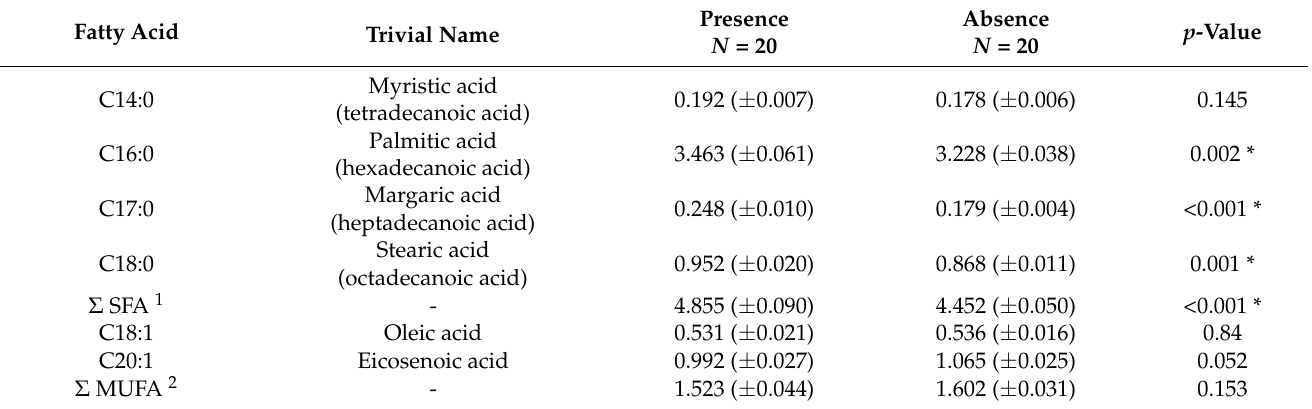
Table 1. Fatty acids composition (mg/g) of groups. Values are mean ± SE. ‘Presence’: the limpet partially covered by the coralline algae, ‘Absence’: the limpet without the coralline algae on the shell.